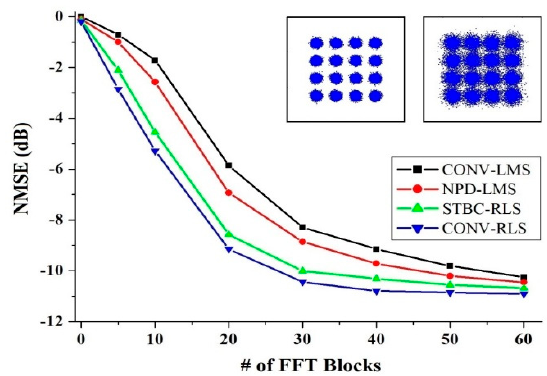
Figure 14. The NMSE vs. the number of FFT blocks for various algorithms for a PDM 16 quadrature amplitude modulation (16QAM) signal; inset: constellation diagrams before ( right ) and after ( left ) the STBC-RLS compensation [27].